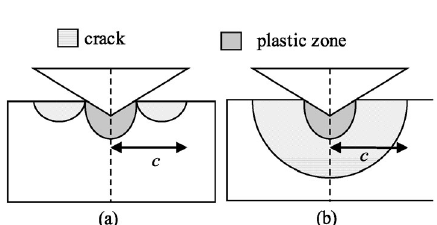
Fig. 6 Crack types: (a) Palmqvist/radial crack, (b) half penny